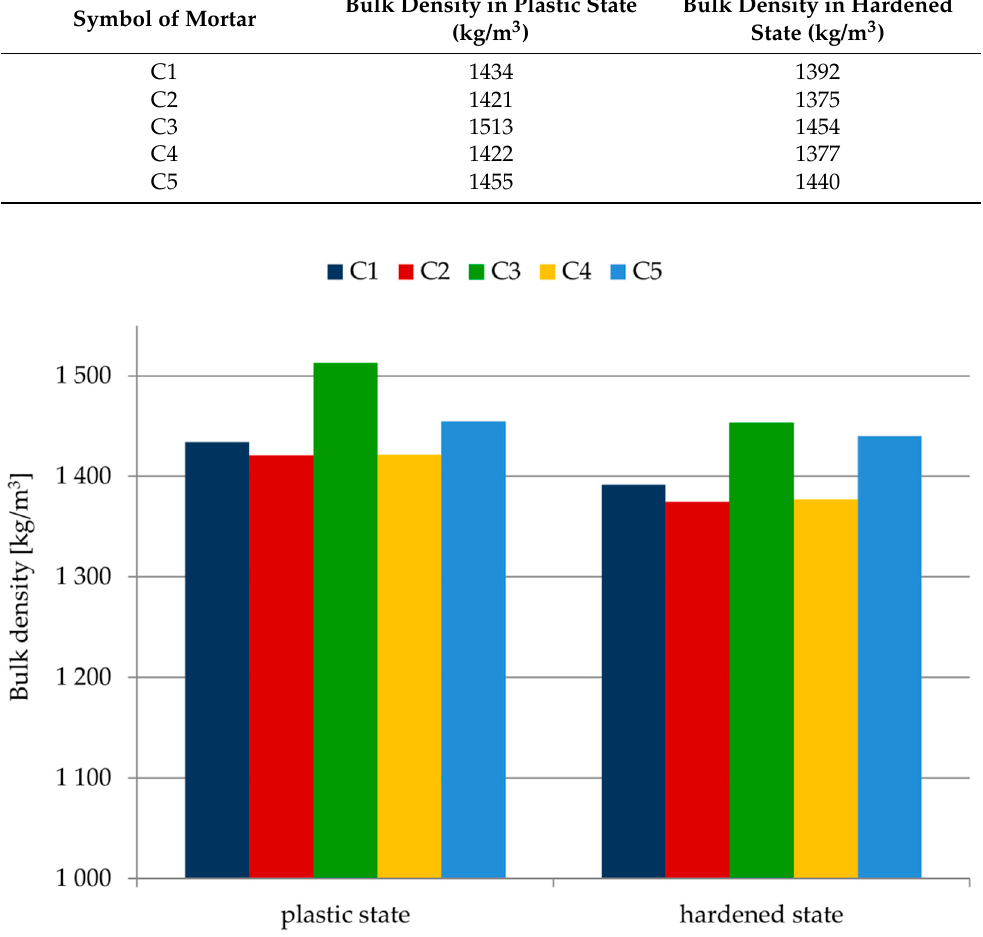
Figure 4. Bulk density results of mortars in plastic and hardened states.